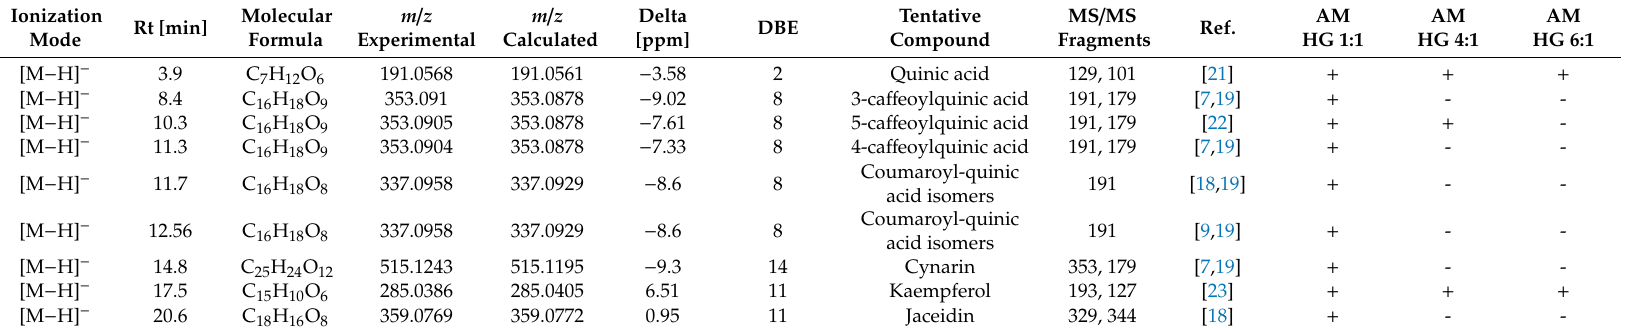
Table 2. Tentatively identified compounds in Achillea millefolium